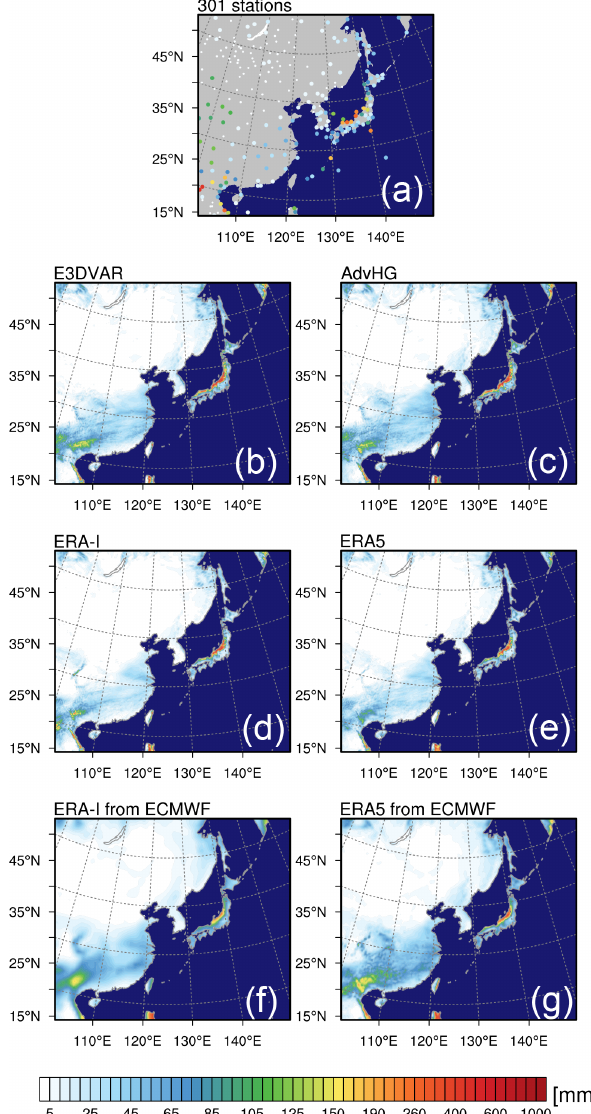
Figure 13. The spatial distribution of the monthly accumulated pre- cipitation of (a) observations, (b) E3DVAR, (c) AdvHG, (d) ERA-I, (e) ERA5, (f) ERA-I from ECMWF, and (g) ERA5 from ECMWF for January 2017.